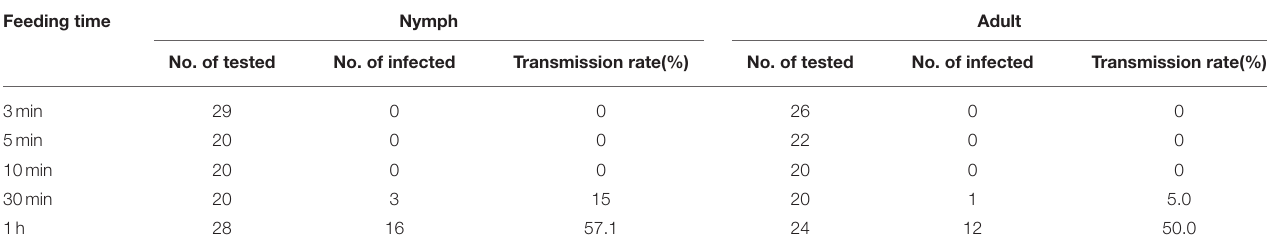
TABLE 2 | The transmission rates of RSMV by Recilia dorsalis individuals. Feeding time Nymph Adult No. of tested No. of infected